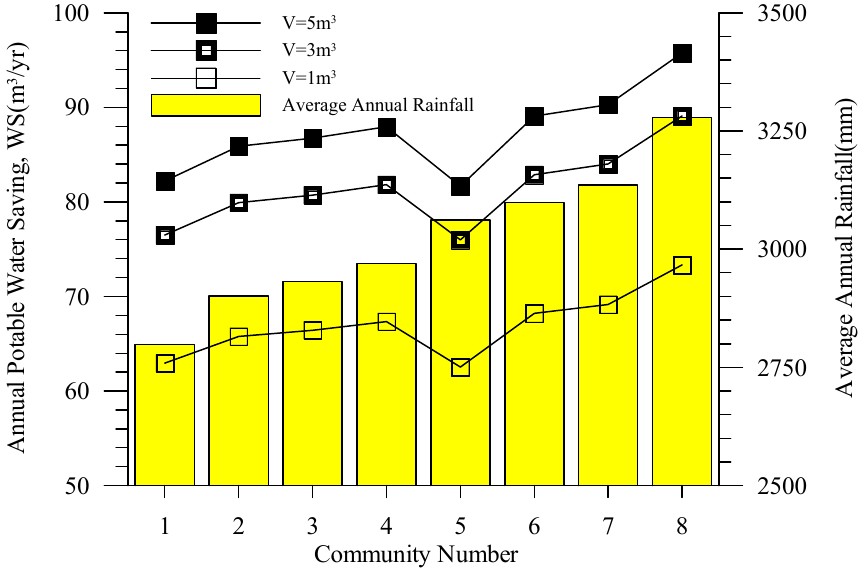
Figure 4. The average annual rainfall and WS of each